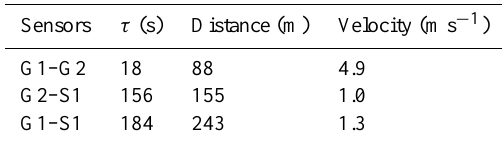
Table 1. Estimation of mean front velocity between the sensors of the upstream seismic network and mean wave velocities estimated with